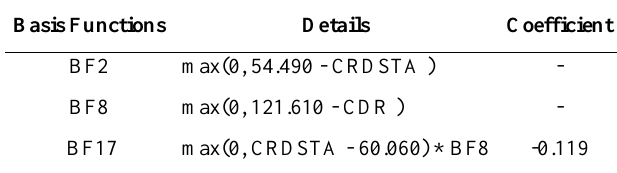
Table 6: Basis Functions of CRDSTA